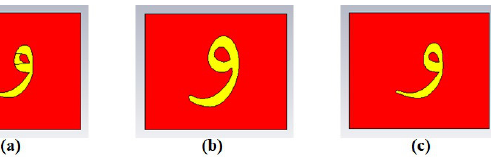
Figure 15. Designed letter (cid:240) tag with various fonts with the same size of 28: ( a ) Arial; ( b ) Calibri; and ( c ) Times New Roman (TNR).